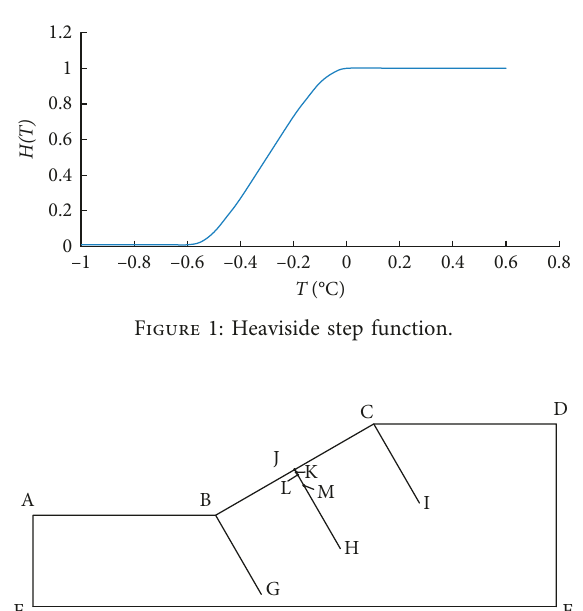
Figure 2: Slope geometric dimensions